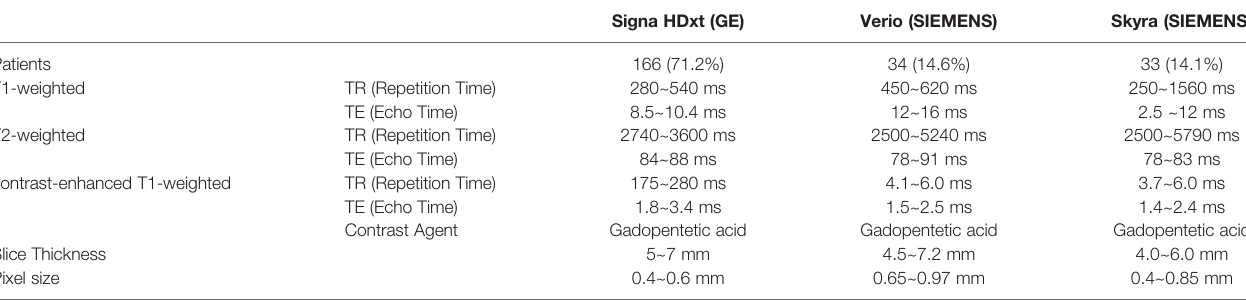
TABLE 2 | MR scan parameters.